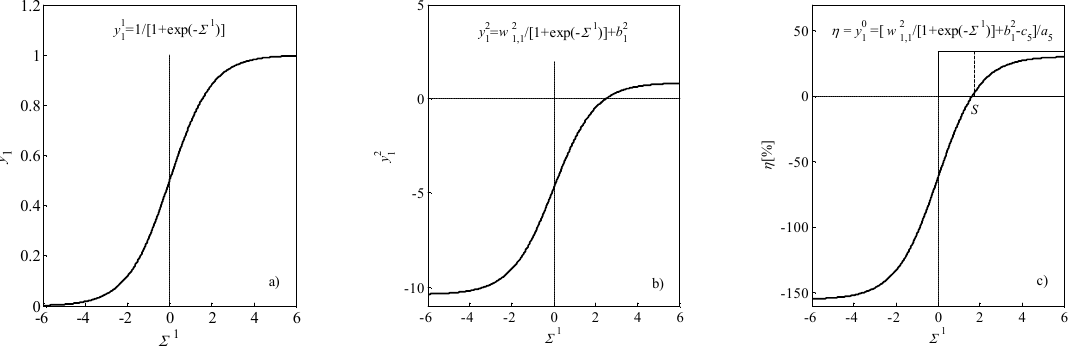
Figure 12. Operations on the logsig function inside the AN.